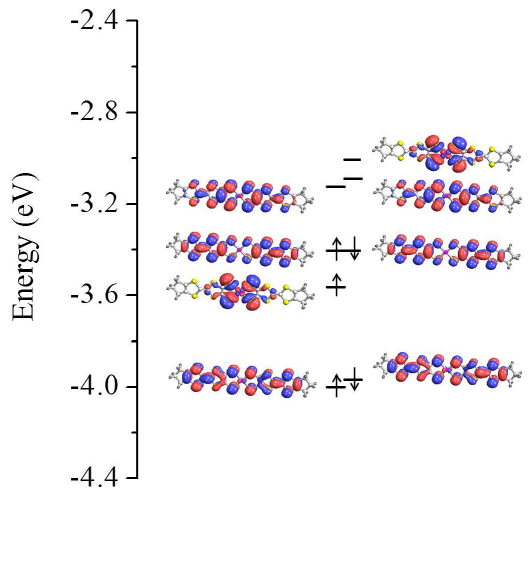
Figure 4. Spin-polarized wavefunctions and energy eigenvalues for planar Cu(tmdt) 2